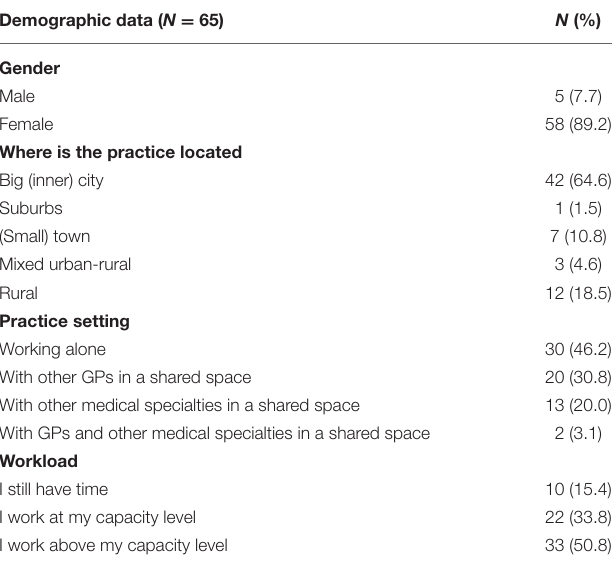
TABLE 3 | GP’s assessment of the degree to which services available to elderly with mental health problems respond to their needs.